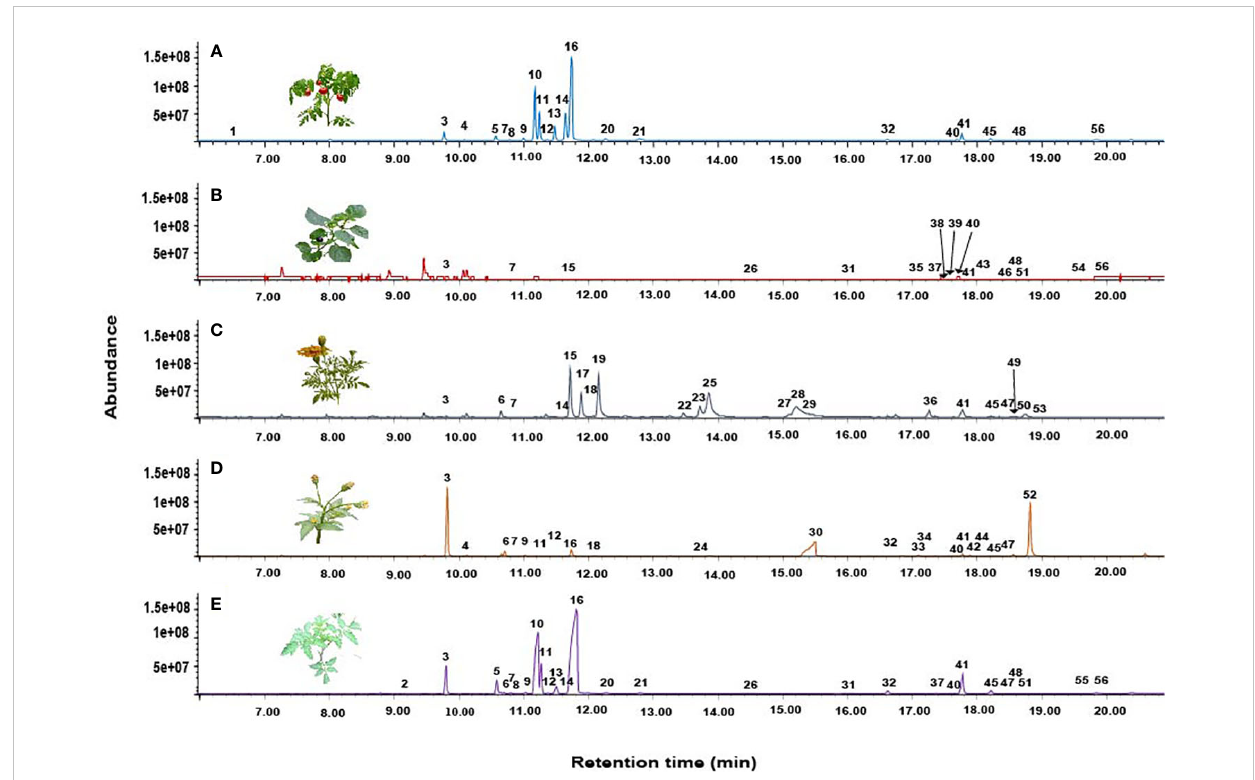
FIGURE 3 Representative total ion chromatograms (TICs) showing the headspace volatile pro fi les (A) Cultivated tomato, (B) Giant nightshade (C) Marigold, (D) Blackjack, and (E) Wild